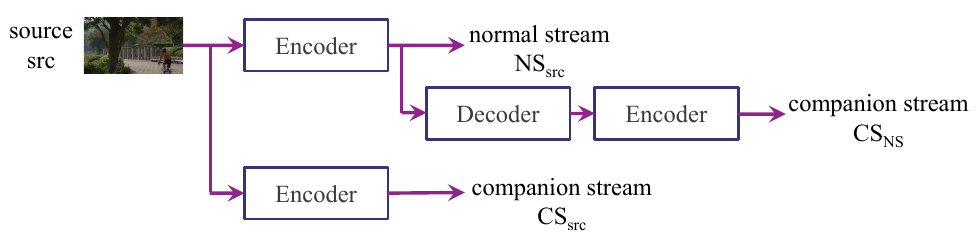
Figure 3. Companion stream CS src is encoded from the source video and CS NS is constructed from the decoded normal